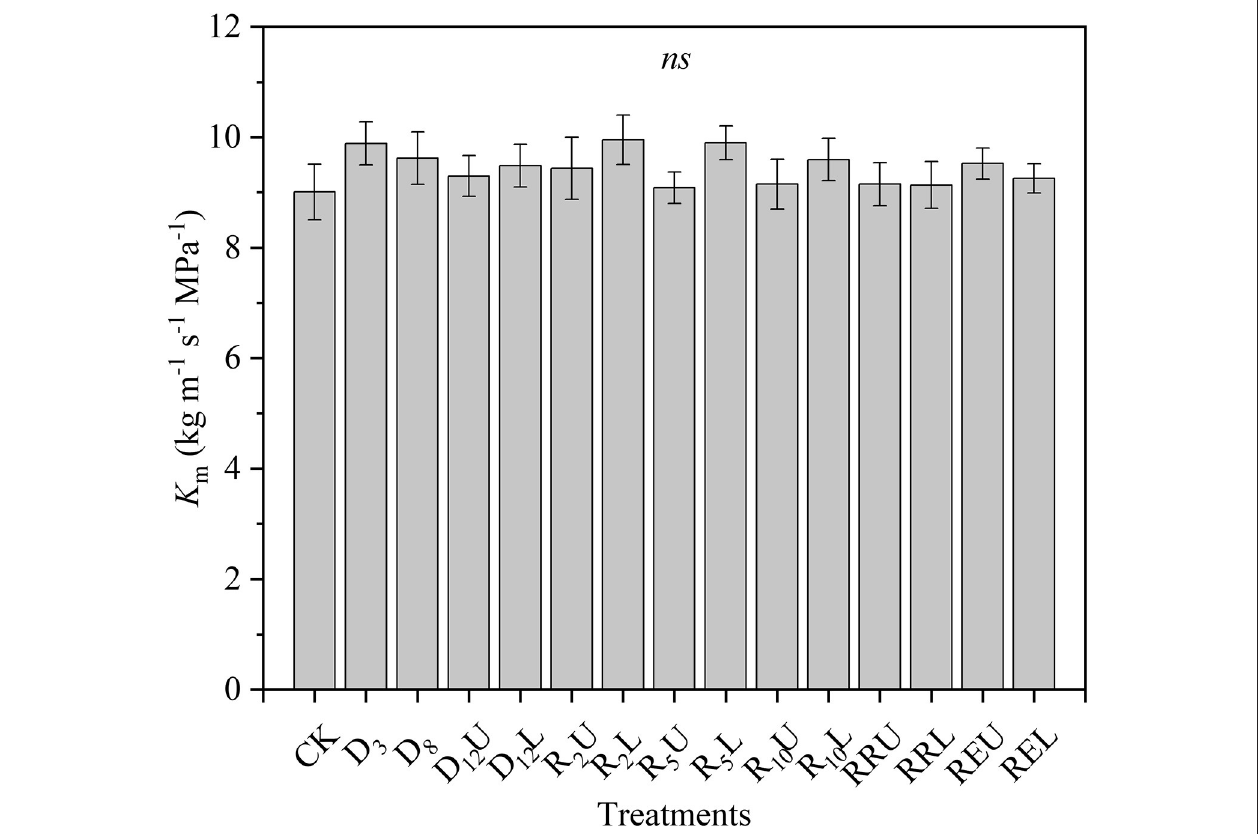
FIGURE 1 | Maximum stem-specific hydraulic conductivity ( K m ) for all treatments. CK, control group; D 3 , mild drought group; D 8 , moderate drought group; D 12 U, upper part of the severe drought group; D 12 L, lower part of the severe drought group; R 2 U, upper part of the 2-day-rewatering group; R 2 L, lower part of the 2-day-rewatering group; R 5 U, upper part of the 5-day-rewatering group; R 5 L, lower part of the 5-day-rewatering group; R 10 U, upper part of the 10-day-rewatering group;